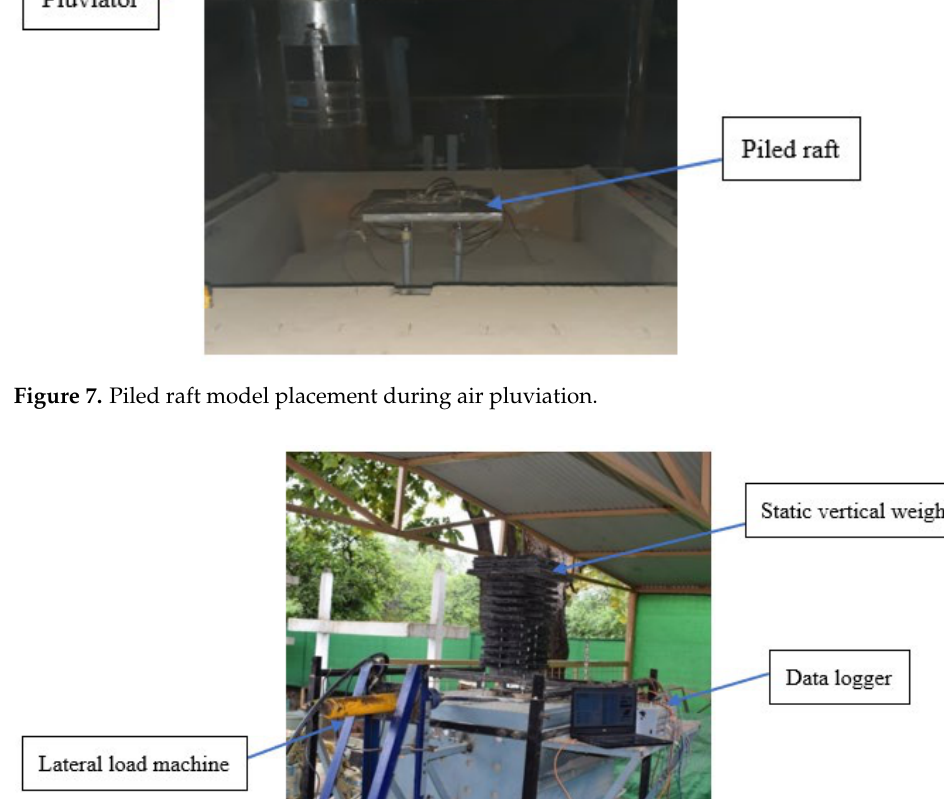
Figure 9. Arrangement for vertical LVDTs. After the vertical static loading test, a connection for lateral load cells was made and connected with the data logger. The purpose of applying the vertical load first, then the lat- eral load, was to simulate the actual condition. As is commonly observed, the foundation is loaded with a superstructure load and then endangered with various types of lateral loads, such as wind load, earthquake, and water pressures, among others. The vertical transducers (LVDTs) were removed, and the lateral transducers were installed and connected to the side of the raft. The lateral load of 1500 N was applied through the hydraulic lateral load machine, and the load cell data were stored in the MATLAB text file. This type of loading machine, shown in Figure 10, is hydraulic and based on having two hydraulic motors equipped with chains. A load cell installed in this machine was of 50 KN capacity and installed at the front of the hydraulic jack, through which a lateral point load was applied by a 50 KN capacity lateral load hydraulic machine, which was fabricated especially for this purpose. The rate of application of the load by the hydraulic pumps was maintained at a very slow rate and was approximately equal to 4.9 N/s. The purpose of applying the load at this much slower rate was to capture the lateral load distribution with the increase in lateral load. As the model